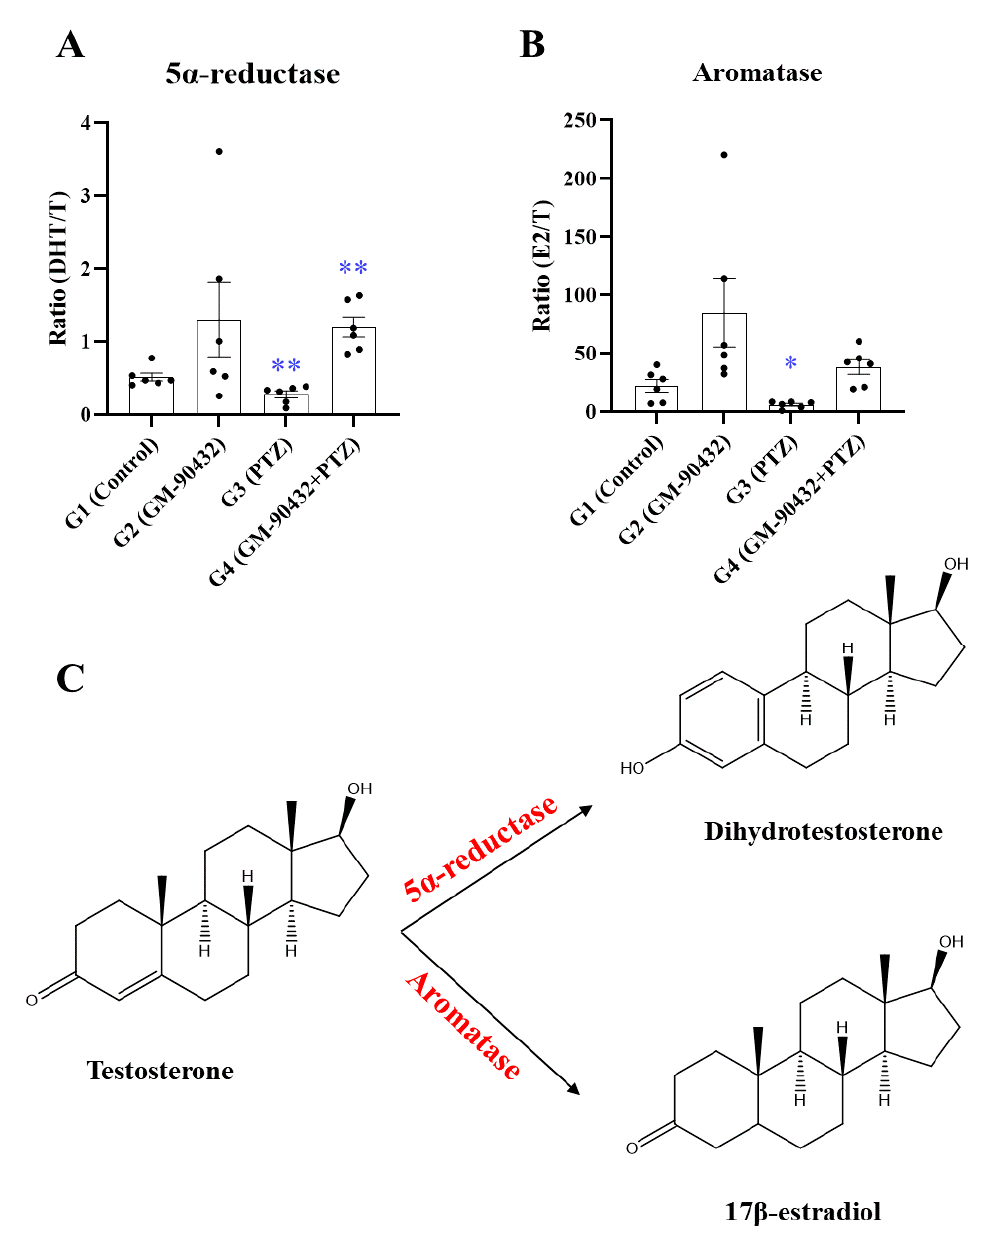
Figure 4. The enzymatic activity by altered metabolic ratio in brain samples of zebrafish. ( A ) Altered metabolic ratio (5 α -reductase) of T to DHT in brain samples of zebrafish exposed to GM-90432, PTZ, or PTZ following pretreatment with GM-90432. ( B ) Altered metabolic ratio (aromatase) of T to E2 in brain samples of zebrafish exposed to GM-90432, PTZ, or PTZ following pretreatment with GM-90432. ( C ) The metabolic pathway of T conversion to DHT or E2. Values represent means ± SEM of 6 samples. Brain samples from 2 individual zebrafish were pooled to form composite samples. Significance between control and exposure groups is indicated by * p < 0.05 or ** p < 0.01.